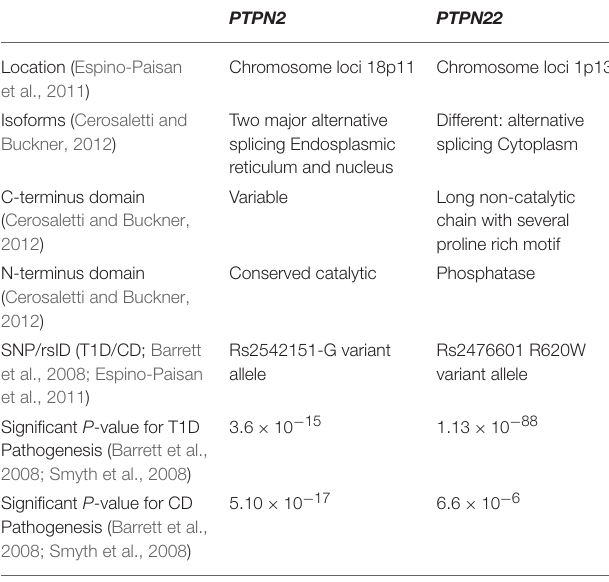
TABLE 1 | Comparative analysis of the two protein tyrosine phosphatases associated with Type 1 Diabetes and Crohn’s disease. PTPN2 PTPN22 Location (Espino-Paisan Chromosome loci 18p11 Chromosome loci 1p13 et al., 2011) Different: alternative Isoforms (Cerosaletti and Two major alternative splicing Buckner, 2012) splicing Endosplasmic reticulum and nucleus